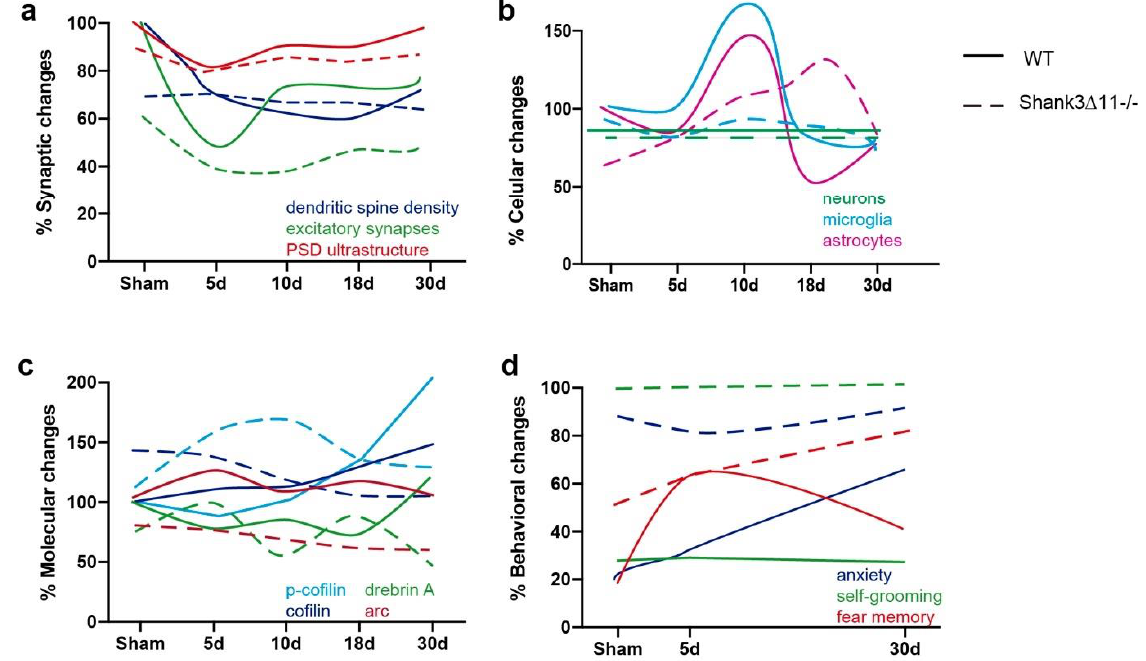
Figure 8. Comparison and time-related changes of the main findings observed in this study between wild-type and Shank3 ∆ 11-/- mice. ( a ) Comparison of the synaptic, ( b ) cellular, ( c ) molecular and ( d ) wild-type and Shank3 ∆ 11 − / − mice. ( a ) Comparison of the synaptic, ( b ) cellular, ( c ) molecular and behavioral differences found between WT and Shank3 ∆ 11-/- before and after the different time ( d ) behavioral differences found between WT and Shank3 ∆ 11 − / − before and after the different time points evaluated after mTBI. points evaluated after